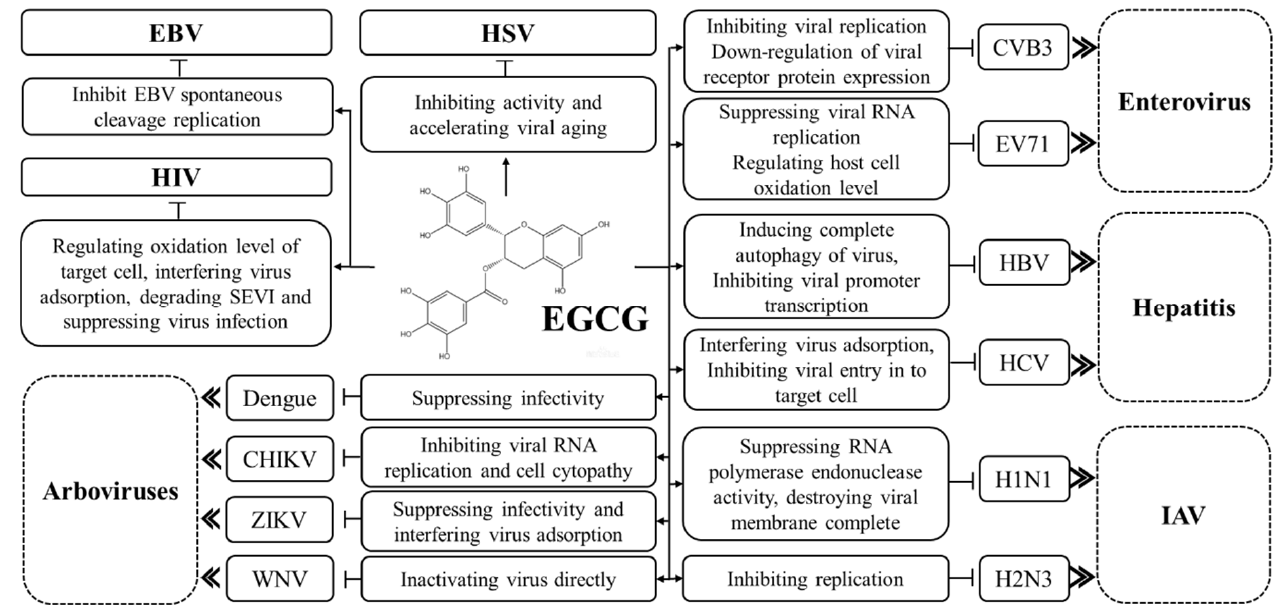
Figure 2. Inhibition effects of EGCG on viruses.